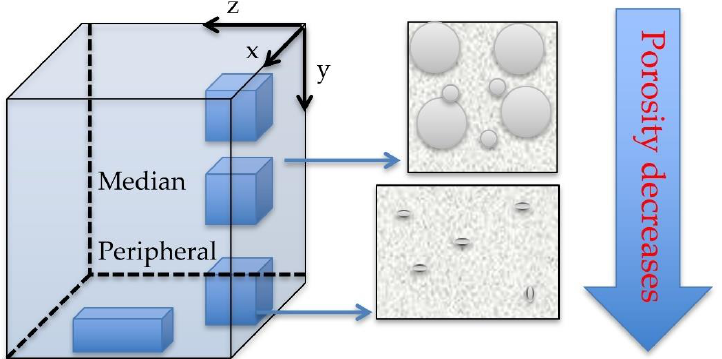
Figure 6. Schematic representation of the porosities in two of the areas to be investigated on the cubic samples in Figure 1a — in relationship with the penetration depth y of the ceramic slurry inside the volume of each cube.